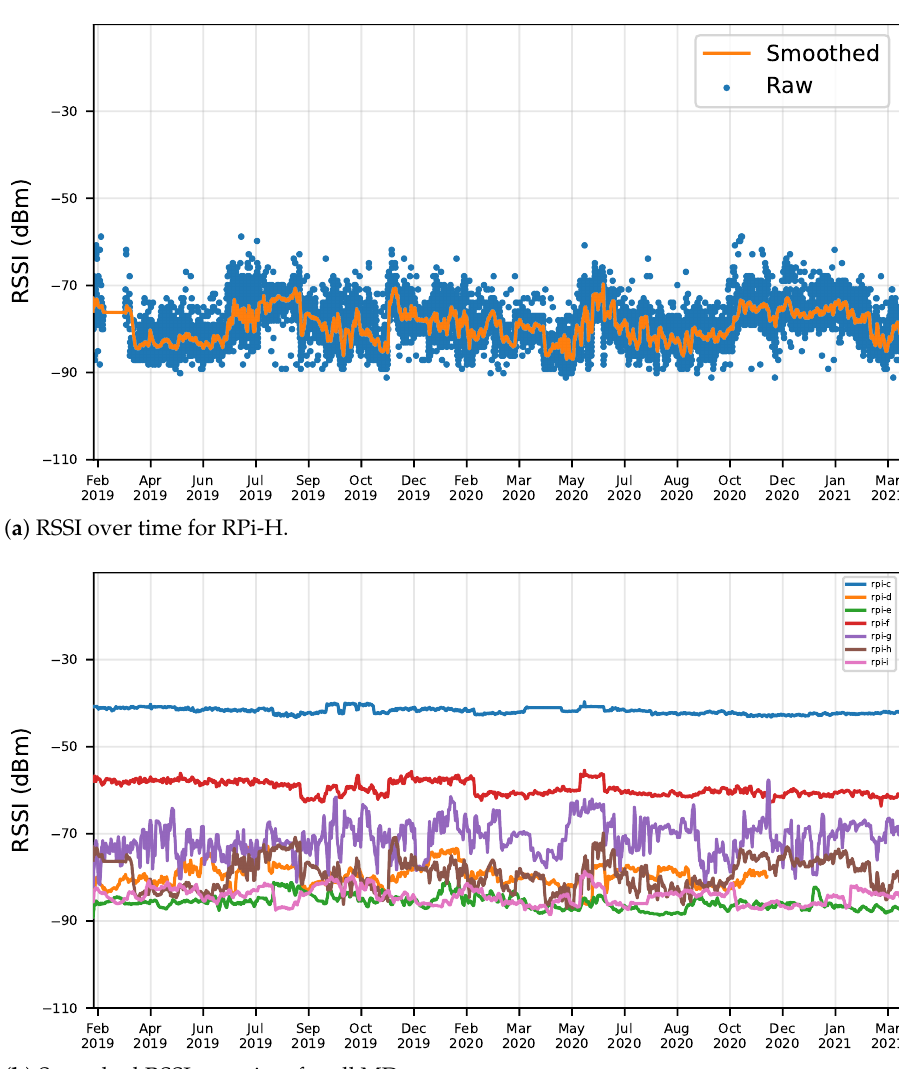
( b ) Smoothed RSSI over time for all MDs. Figure 8. RSSI over time for AP